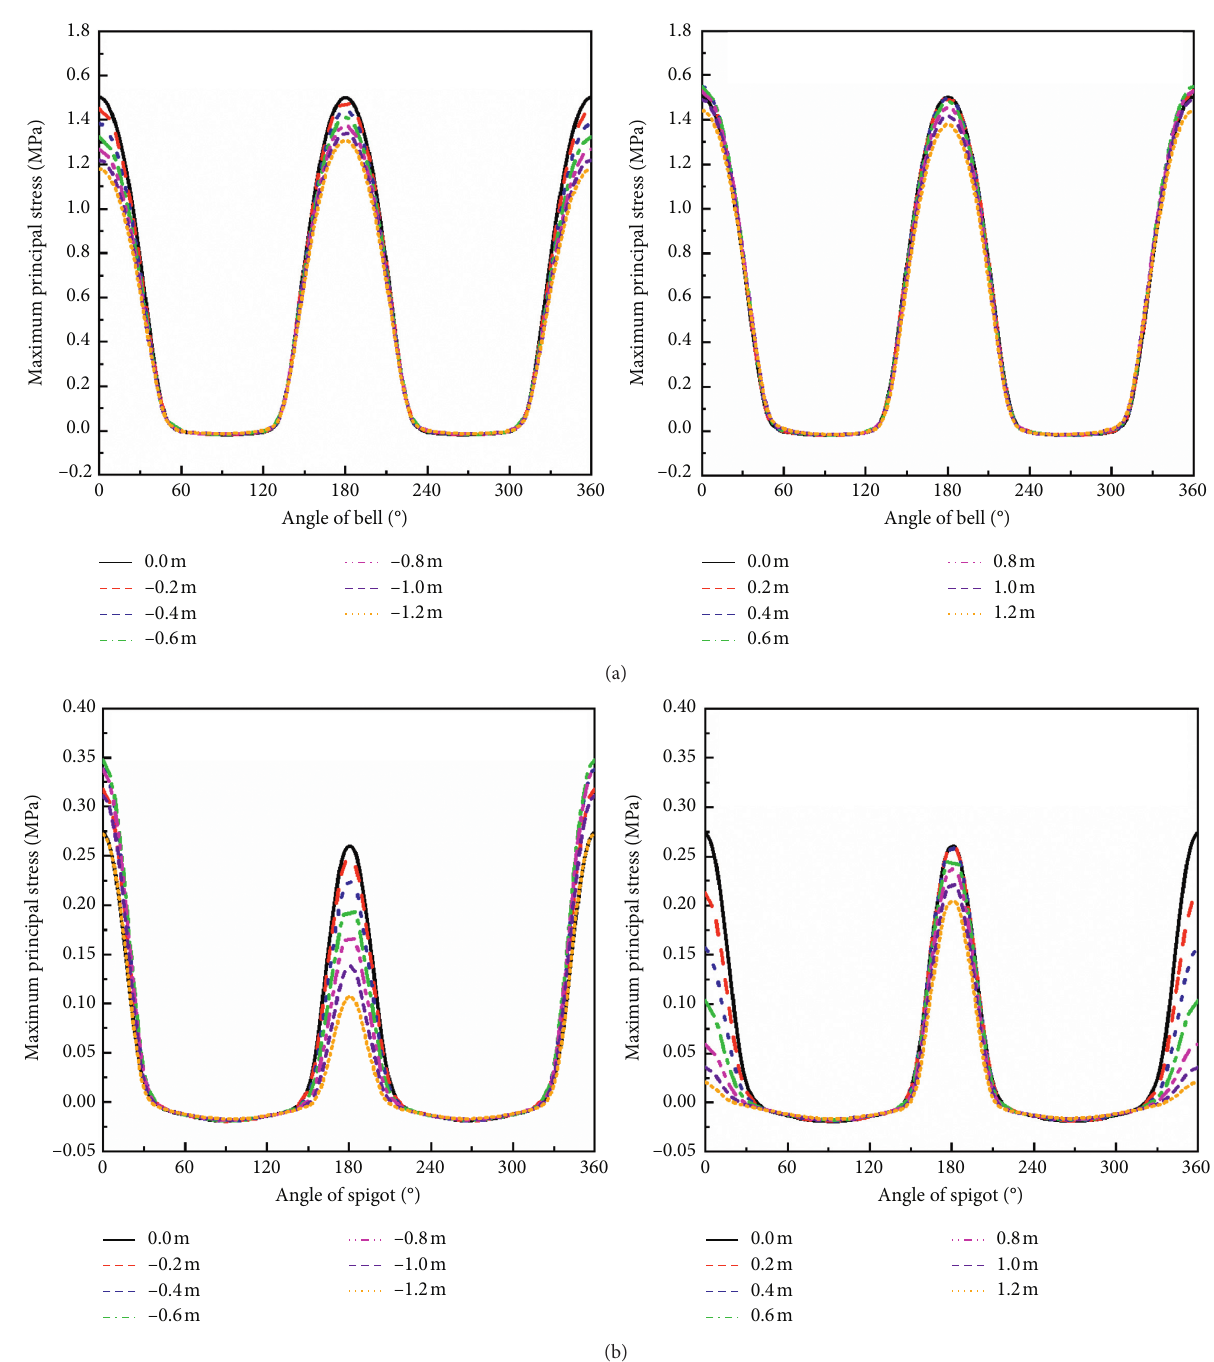
Figure 27: Maximum principal stress of (a) the bell and (b) the spigot with different load